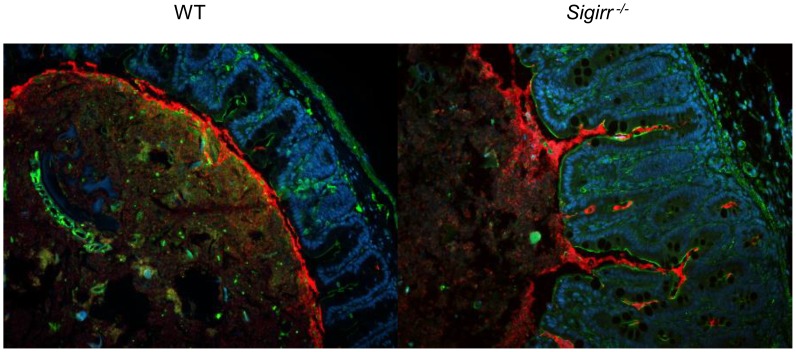
Immunofluorescence staining of C. jejuni cecal colonization in vivo.Formalin-fixed tissue sections of ceca obtained from C. jejuni-infected WT and Sigirr−/− mice 7 DPI at ×200 magnification. Cell nuclei are stained with DAPI (blue), epithelial cells are outlined with antibodies specific to β-actin (green), and C. jejuni (red) are clearly visible around the edge of the lumen and into the cecal crypts.